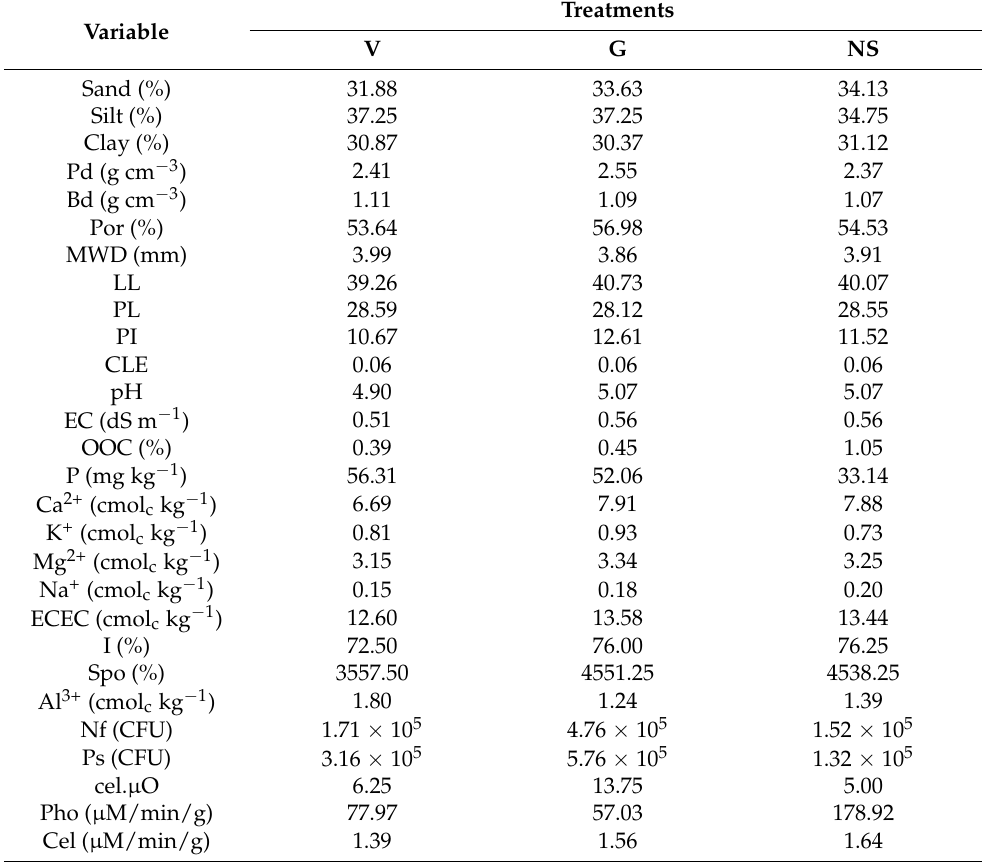
Table 2. Physical, chemical, microbiological and enzyme activity mean values for the pruning treatments: spherical vase shape (V), globe shape (G) and natural shape (NS).